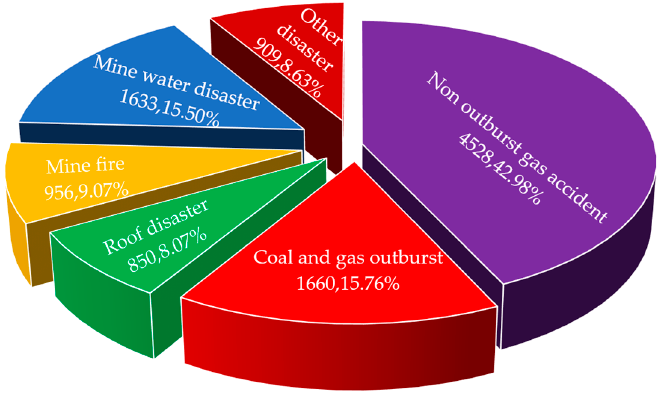
Figure 1. Pie chart of the mine accident distribution.